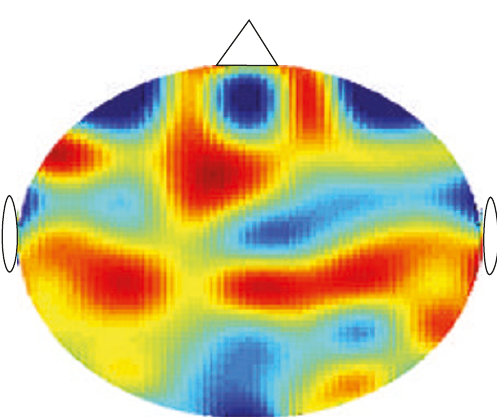
Figure 17: Distribution of visual P300 over the scalp electrodes. It can be seen that the P300 is distributed in a di ff erent way over the electrodes than the auditory P300.